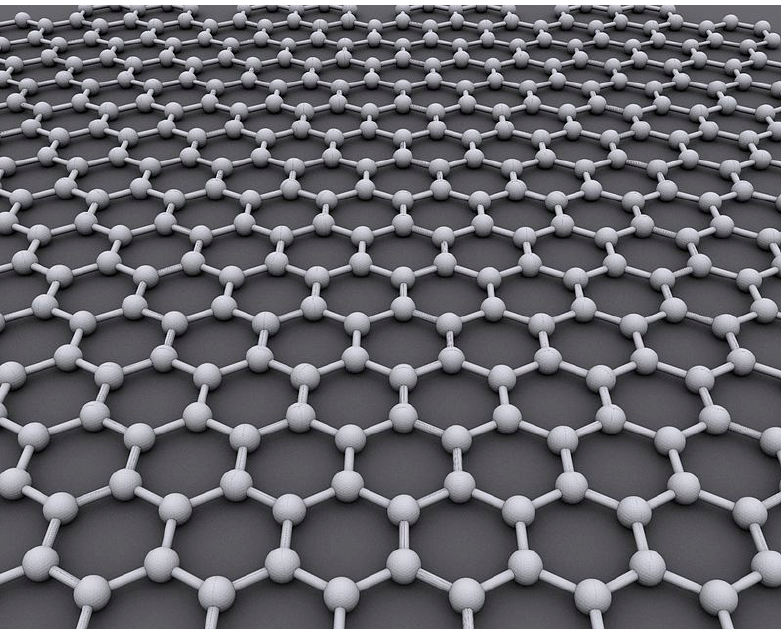
Figure 2. Graphene is an atomic-scale hexagonal lattice made of carbon atoms.